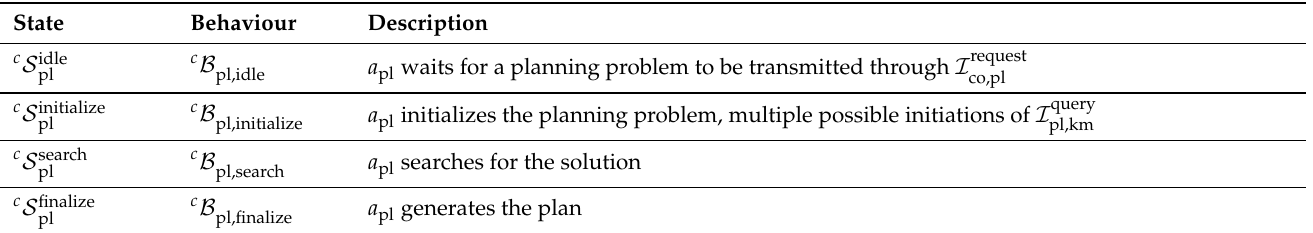
Table 4. Mapping of the states of c